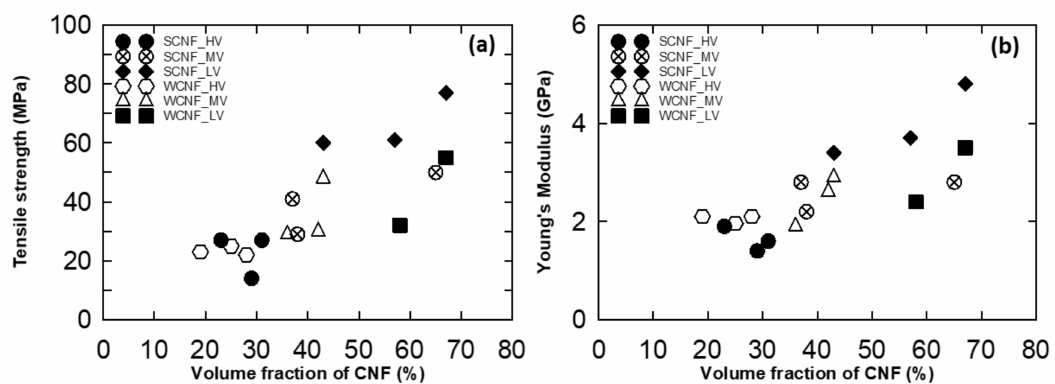
Figure 11. ( a ) Tensile strength vs. volume fraction of CNF in nanocomposite films and ( b ) Young’s modulus vs. volume fraction of CNF in nanocomposite